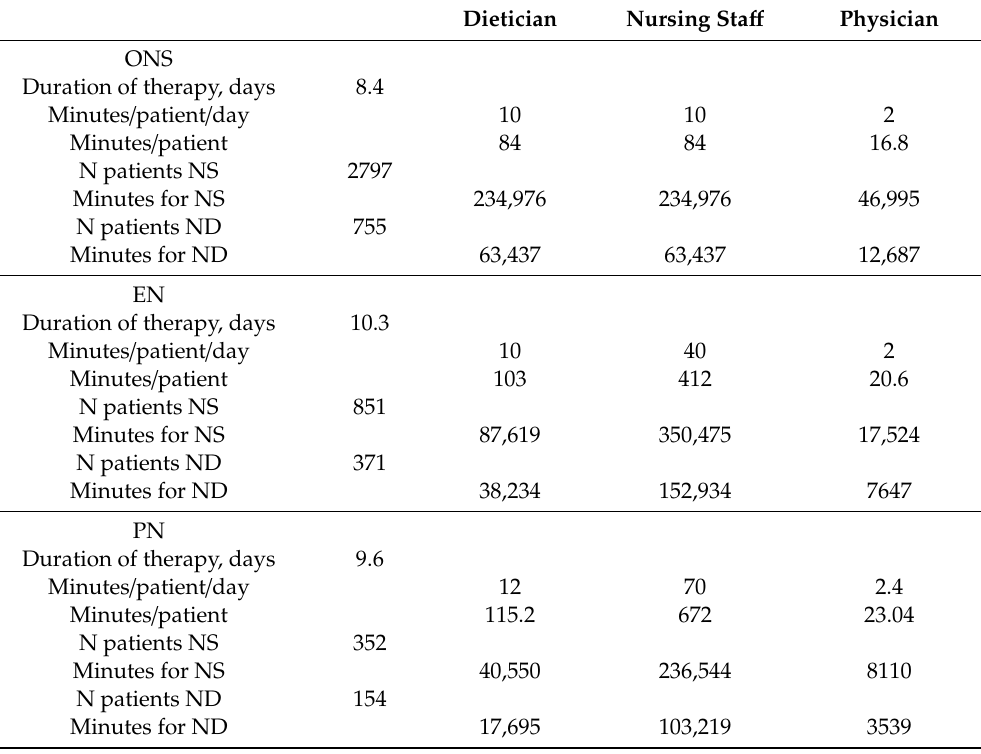
Table A4. Sta ff time per nutritional intervention and professional group. Dietician Nursing Sta